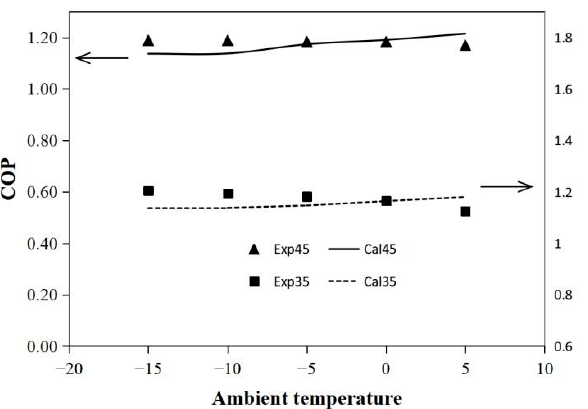
Figure 6. Comparison of calculation and experimental results under different conditions (45 °C/35 °C hot water temperature).